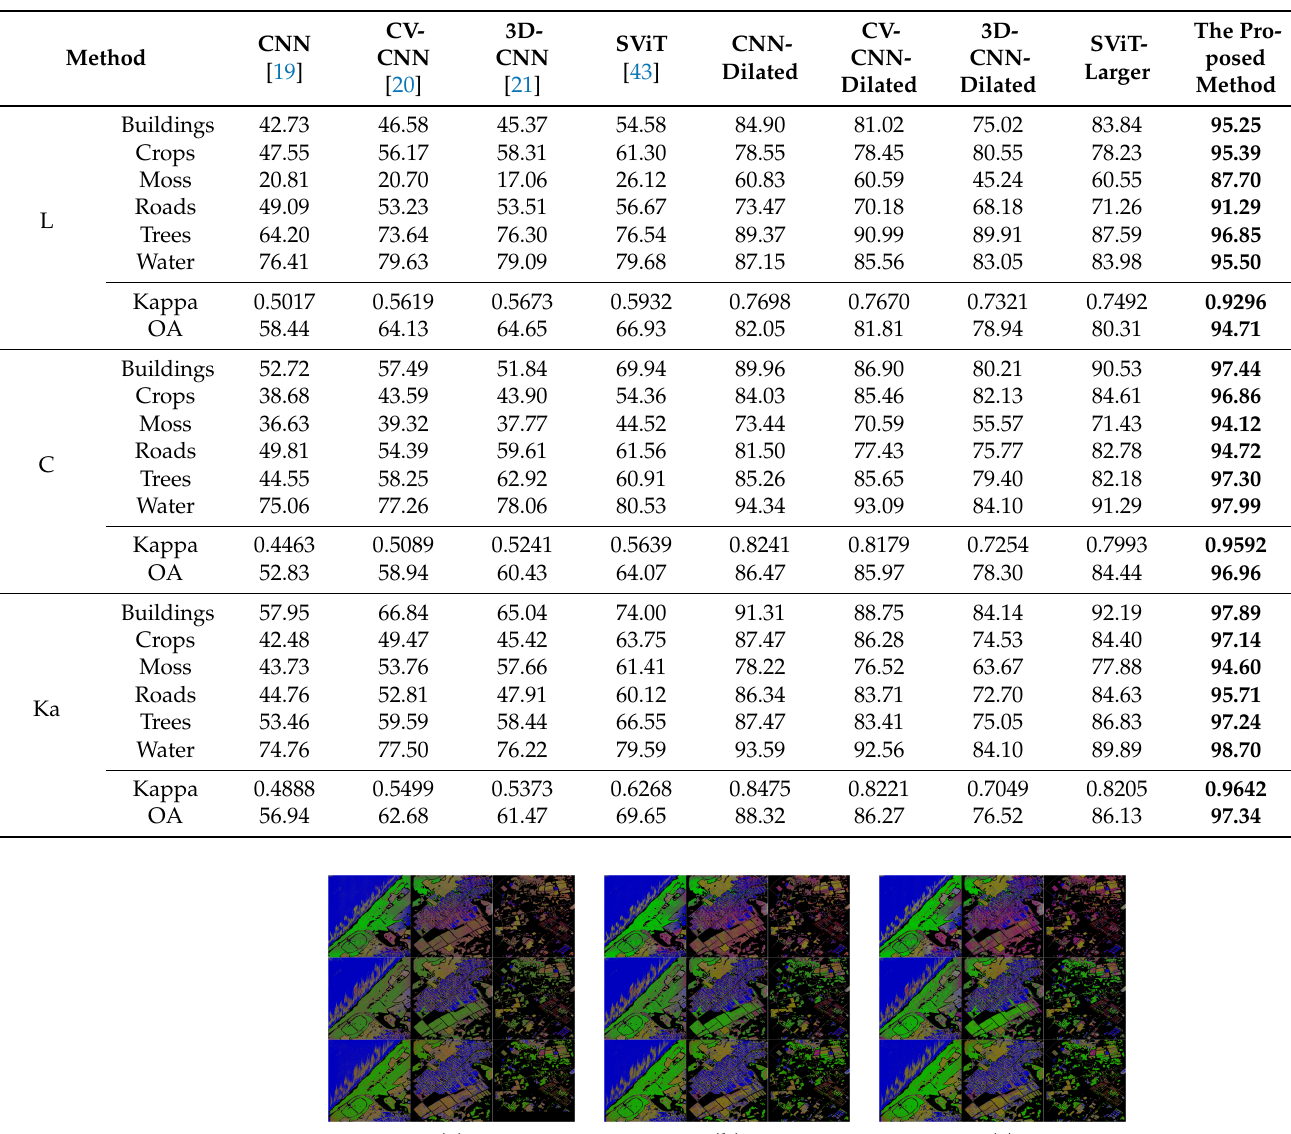
Table 5. Classification results on the Hainan dataset.